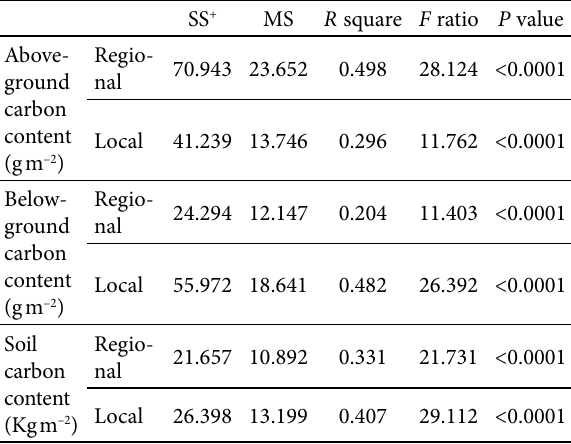
Table 3. Summary of the ANOVA results, shows the different influence of regional and local factors on three carbon pools in alpine grassland of Tibetan Plateau SS +